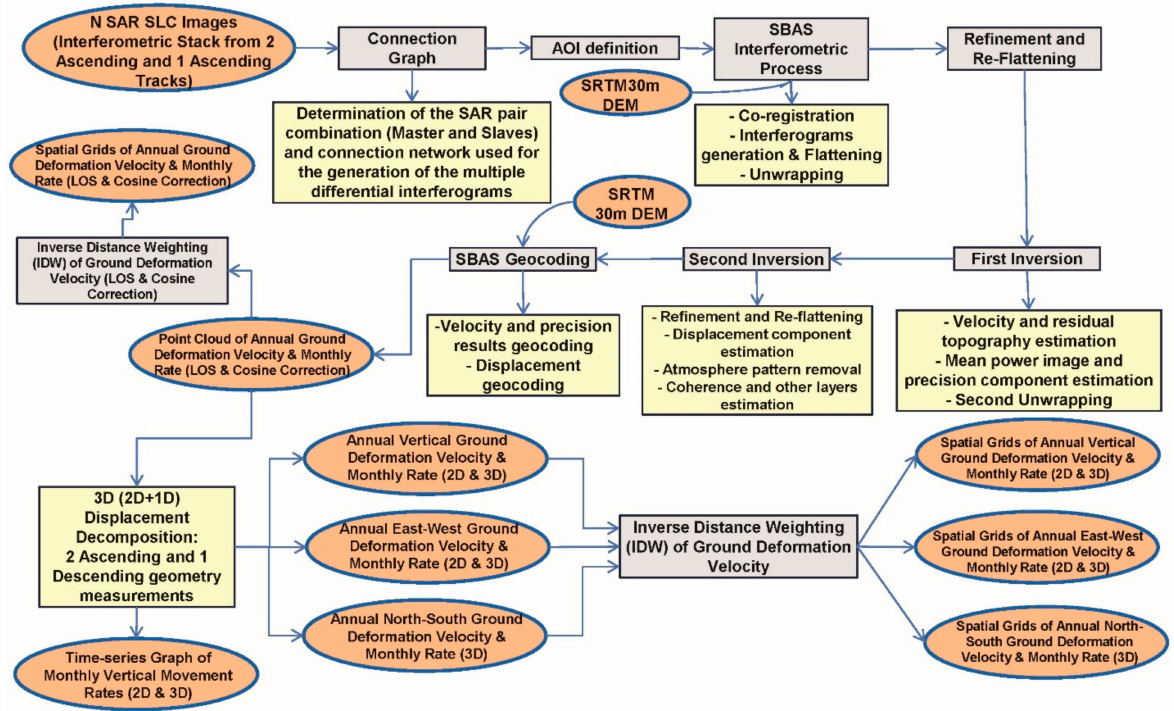
Figure 3. Workflow of SBAS interferometric processing followed by 2D and 3D decompositions, cosine correction and geostatistical